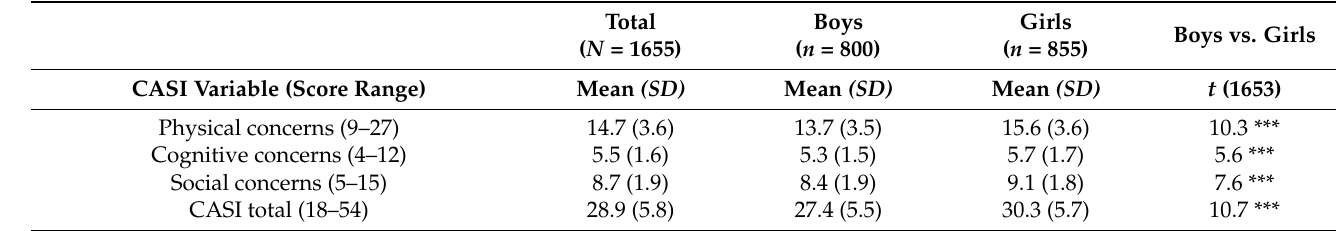
Table 6. Means and standard deviations ( SDs ) of the CASI as a function of